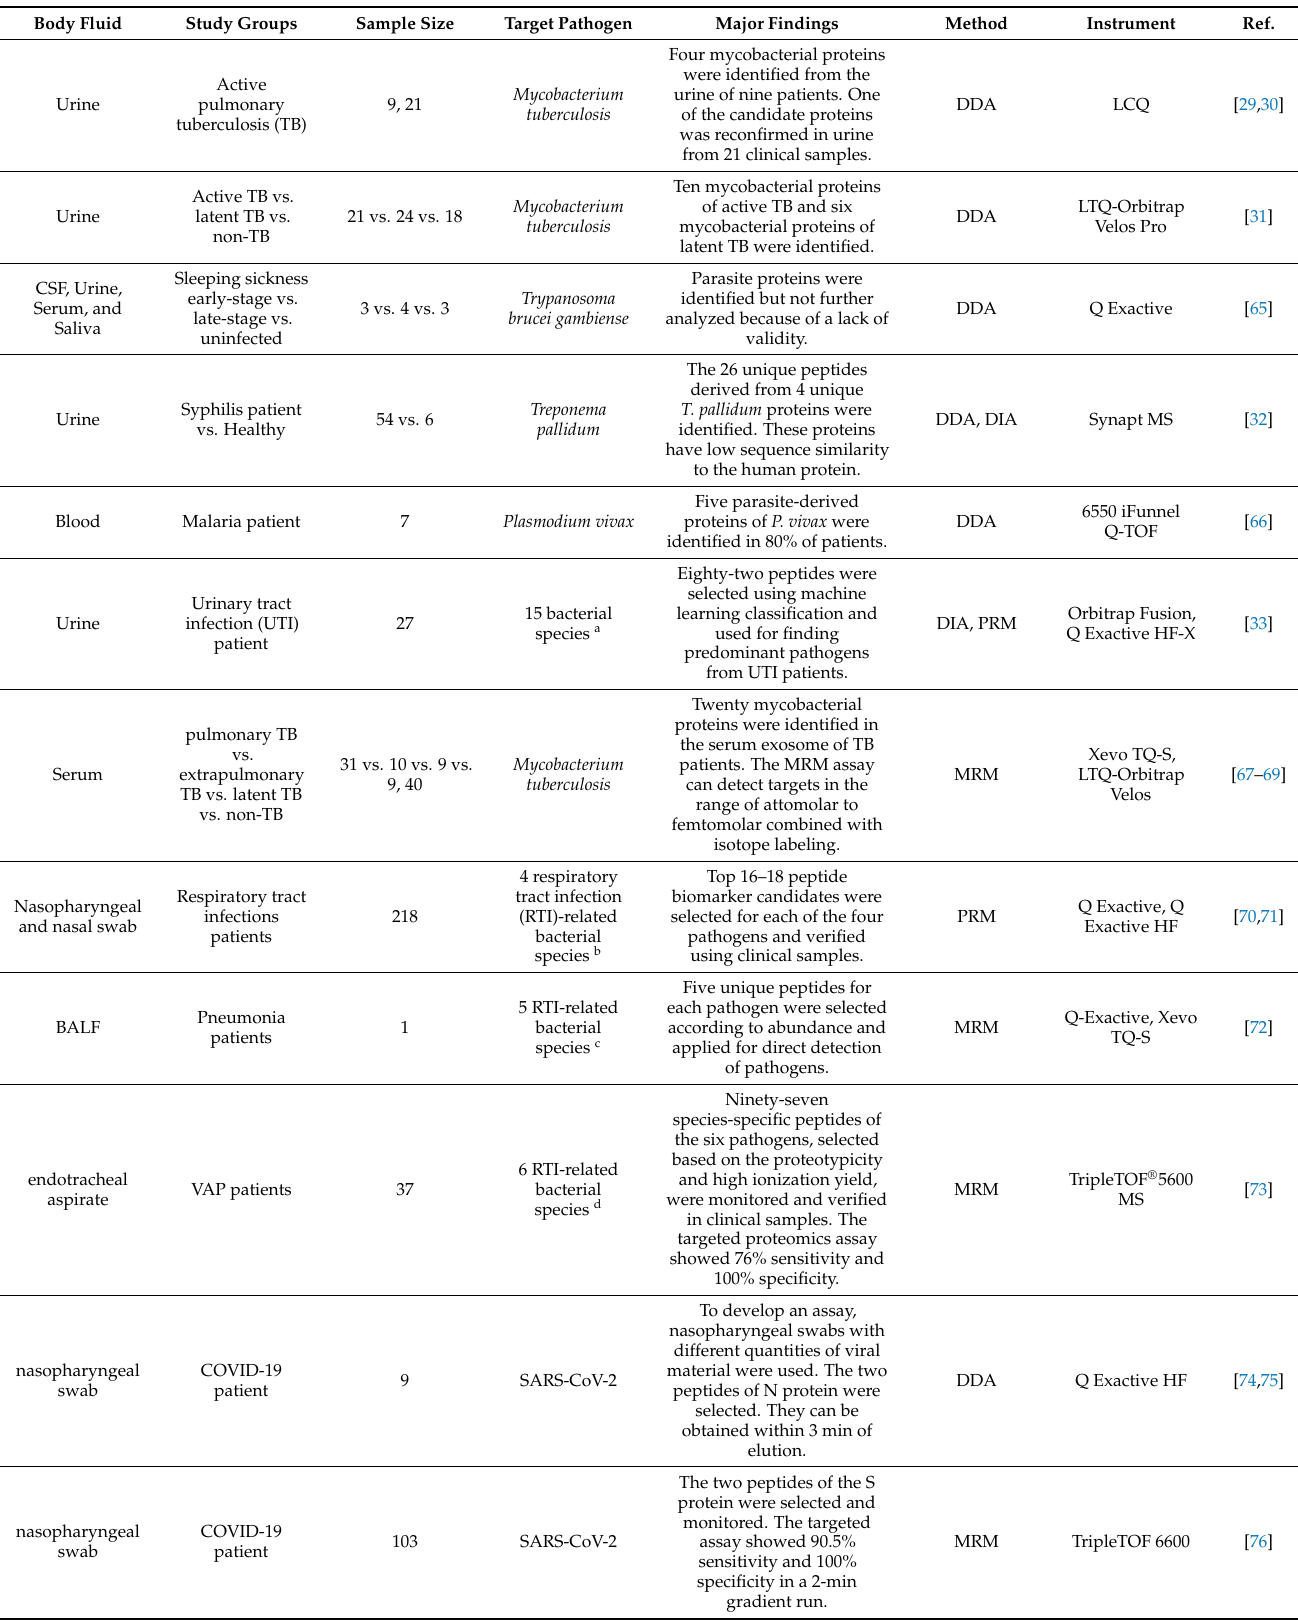
Table 4. Summary of body fluid proteomics for targeting pathogen-derived